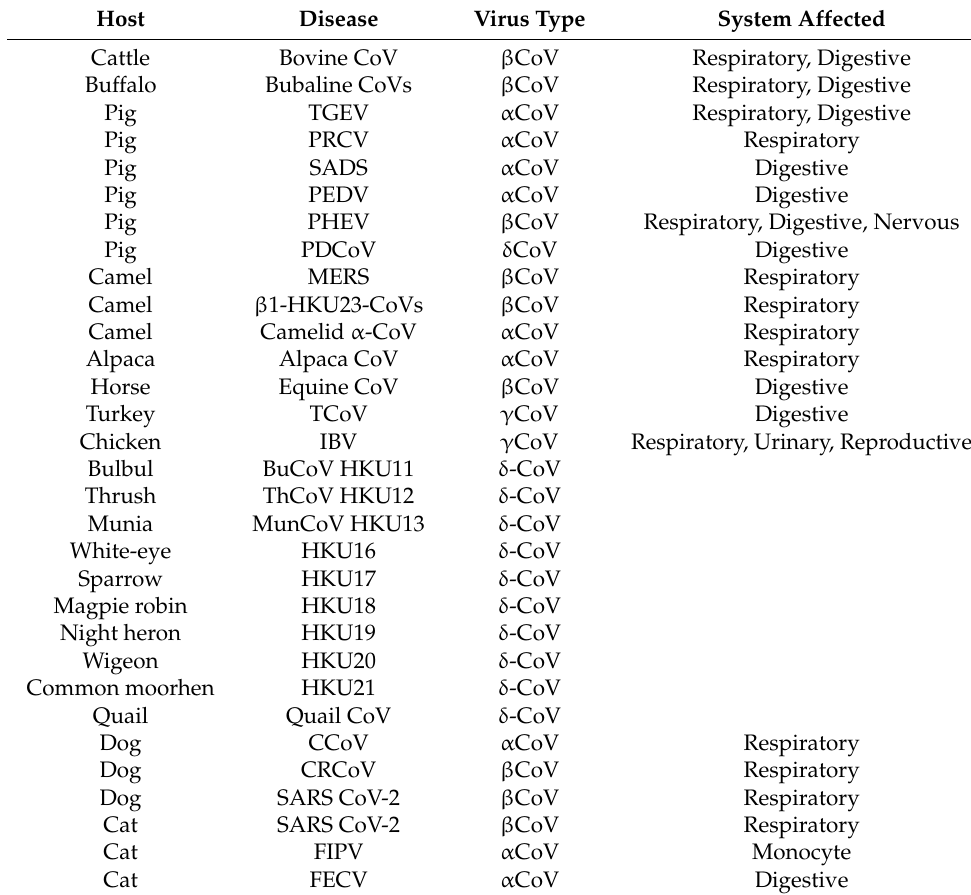
Table 2. Coronavirus diversity in domestic animals and